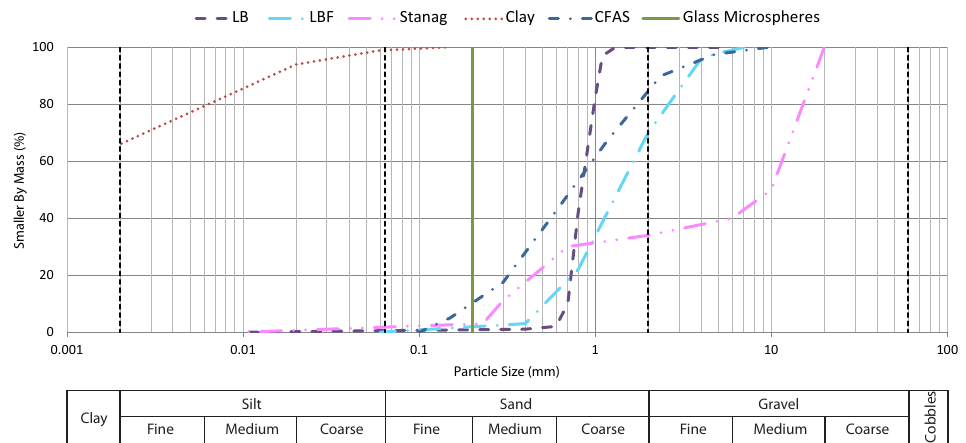
Figure 1. Particle Size Distribution (PSD) curves of a range of soils tested in the literature. LB, LBF, Clay [13]; Stanag [17]; CFAS (Centre of Allowable Bounds) [18]; and Glass Microspheres